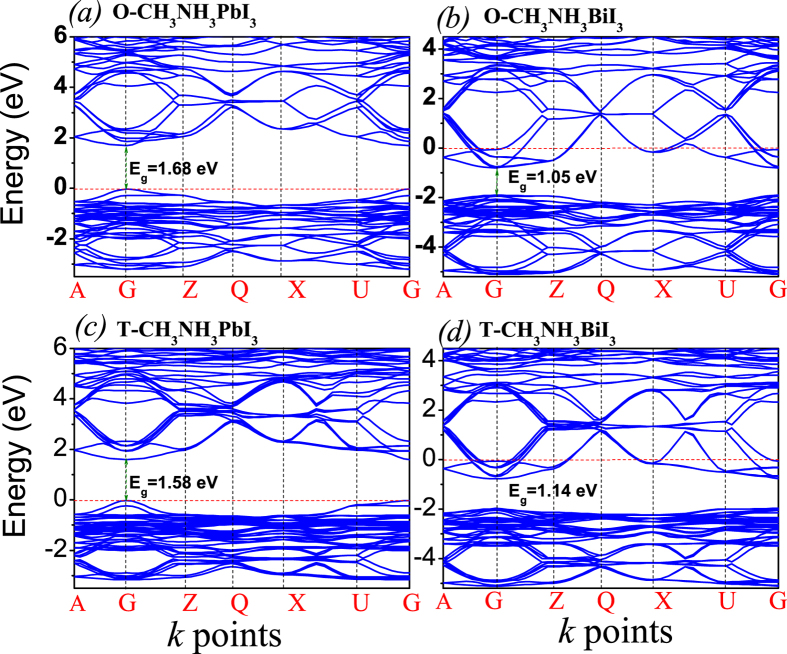
The calculated band structures of O-CH3NH3PbI3 (a), O -CH3NH3BiI3 (b), T-CH3NH3PbI3 (c), and T-CH3NH3BiI3 (d). The red dashed lines represent the Fermi level.